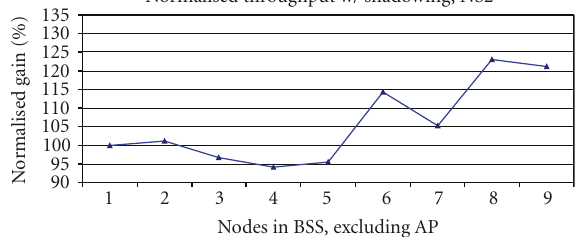
Figure 12: NS-2 normalized gain with